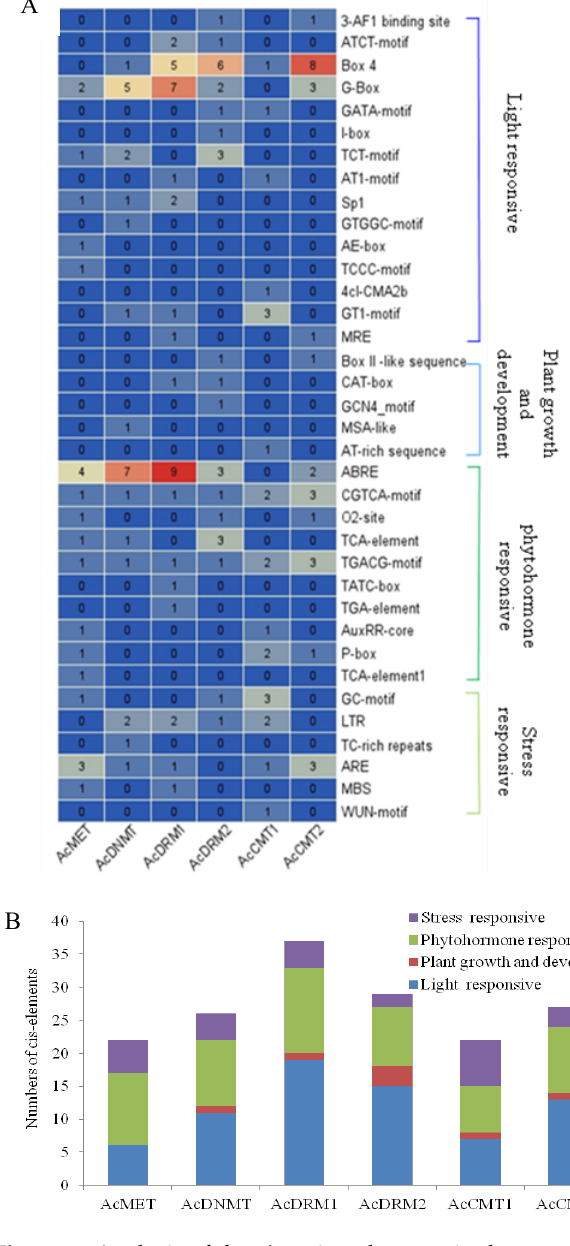
Figure 5. Analysis of the cis -acting elements in the promoters of AcC5-MTases. ( A ) Numbers of different promoters of AcC5-MTases. ( B ) Cis -acting elements in four categories are represented by different colors.